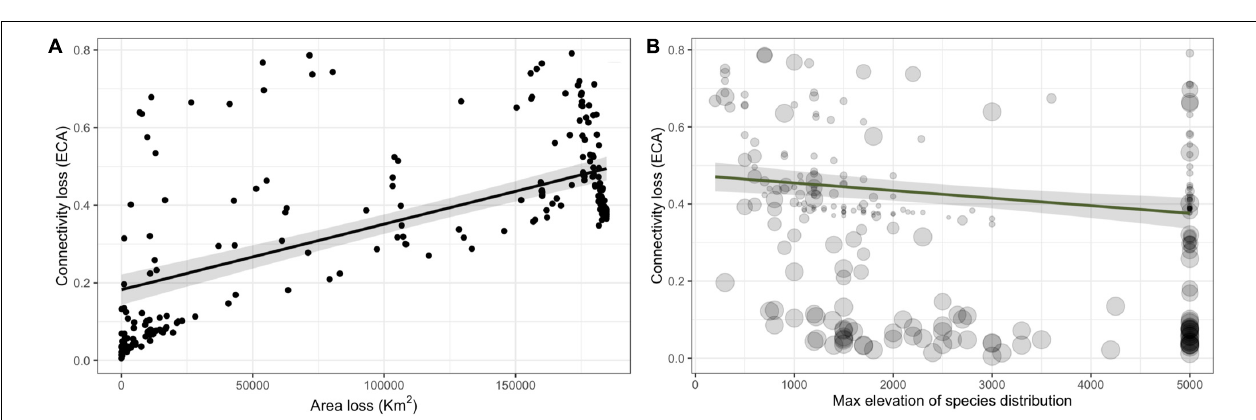
FIGURE 3 | Changes in area of habitat (area) and Equivalent Connected Area (ECA) between 1973 and 2015 for 245 forest vertebrates (birds and mammals). Student’s t -test between area of habitat between 1973 and 2015 shows statistically significant differences ( p < 0.01). The same was true for differences between ECA in 1973 and 2015 ( p < 0.01).